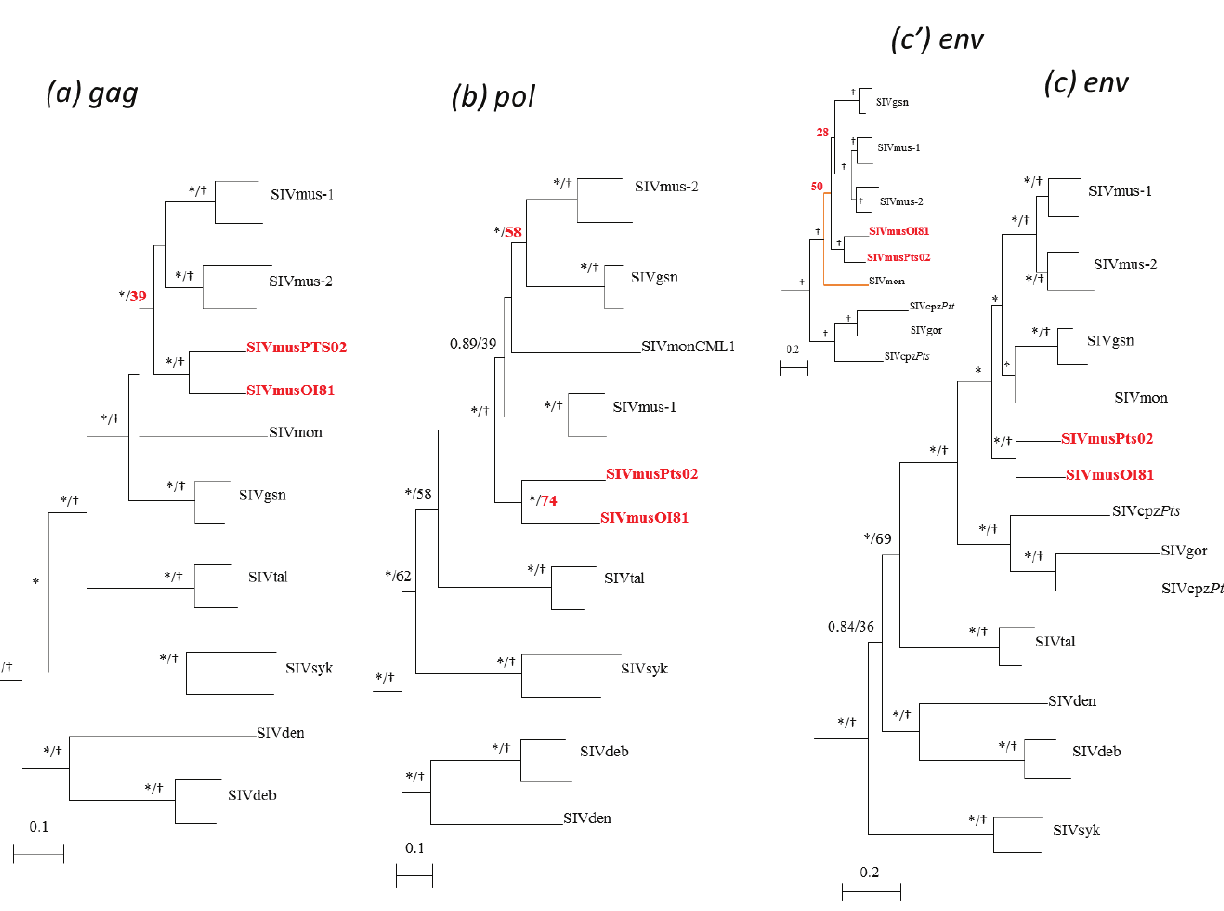
Figure 3. Phylogenetic relationships of the newly derived SIVmus sequences to other SIV lineages in the three major genes. gag ( 1228 nt ) ( a ), pol ( 2772 nt ) ( b ), and env ( 1953 ) ( c ). Only sequences of interest are shown. Phylogenies were inferred using both Bayesian and Maximum Likelihood methods implemented in Mr Bayes and PhyML, respectively, under the GTR + Γ + I model of evolution. Stars and crosses at nodes represent 4 posterior probability ( ≥ 90%) and bootstrap values ( ≥ 80%), respectively. Scale bars indicate substitution per site. In env , the tree topologies differed according the phylogenetic method used. In the figure, ( c ) represents the topology done for env by using the bayesian method whereas ( c’ ) represents the topology done by using PhyML